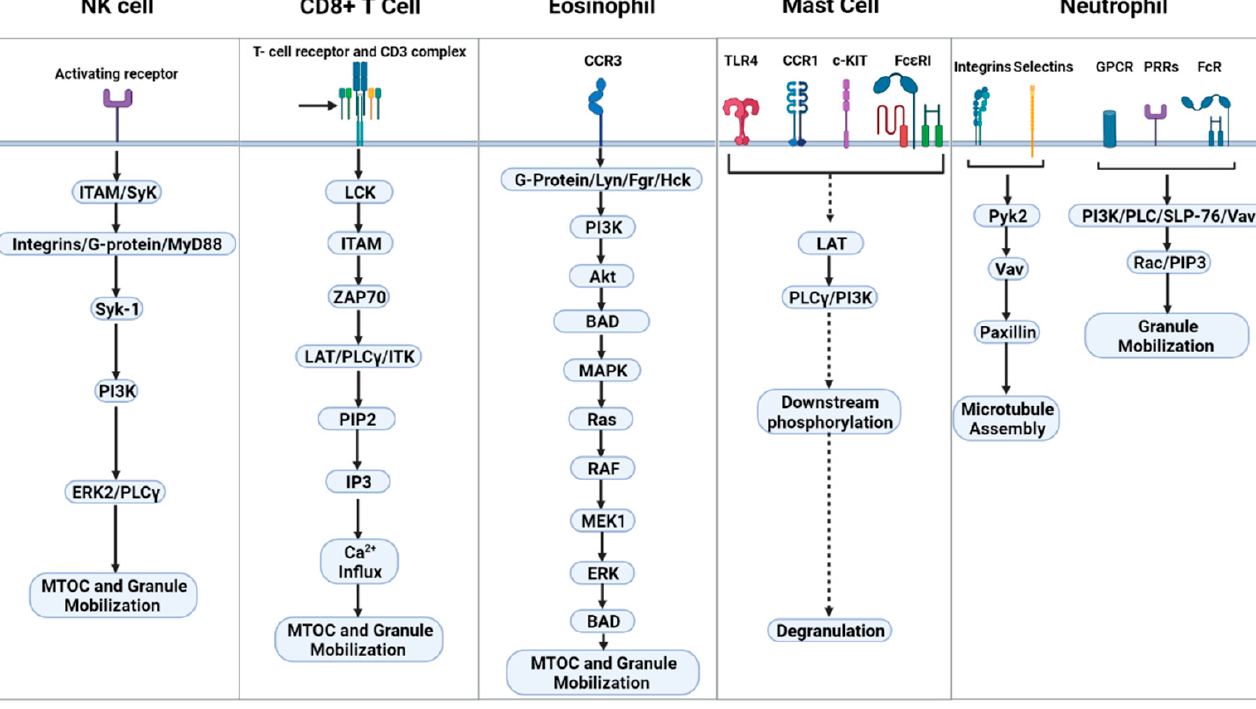
Figure 2. Canonical signaling pathways of granule trafficking.